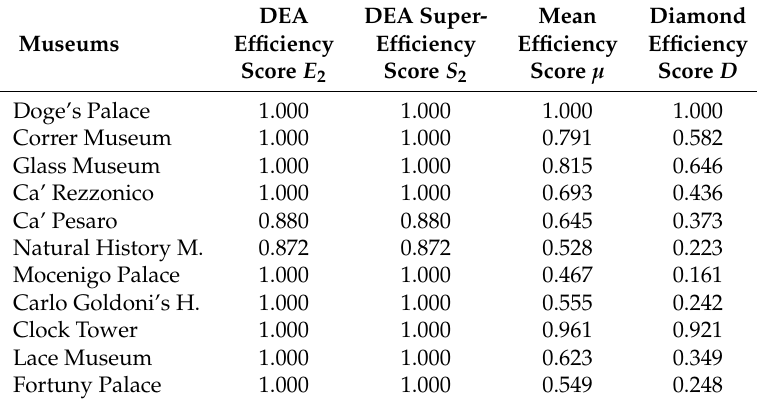
Table 11. Efficiency measures computed at the second stage: DEA, super-efficiency, mean, and diamond efficiency